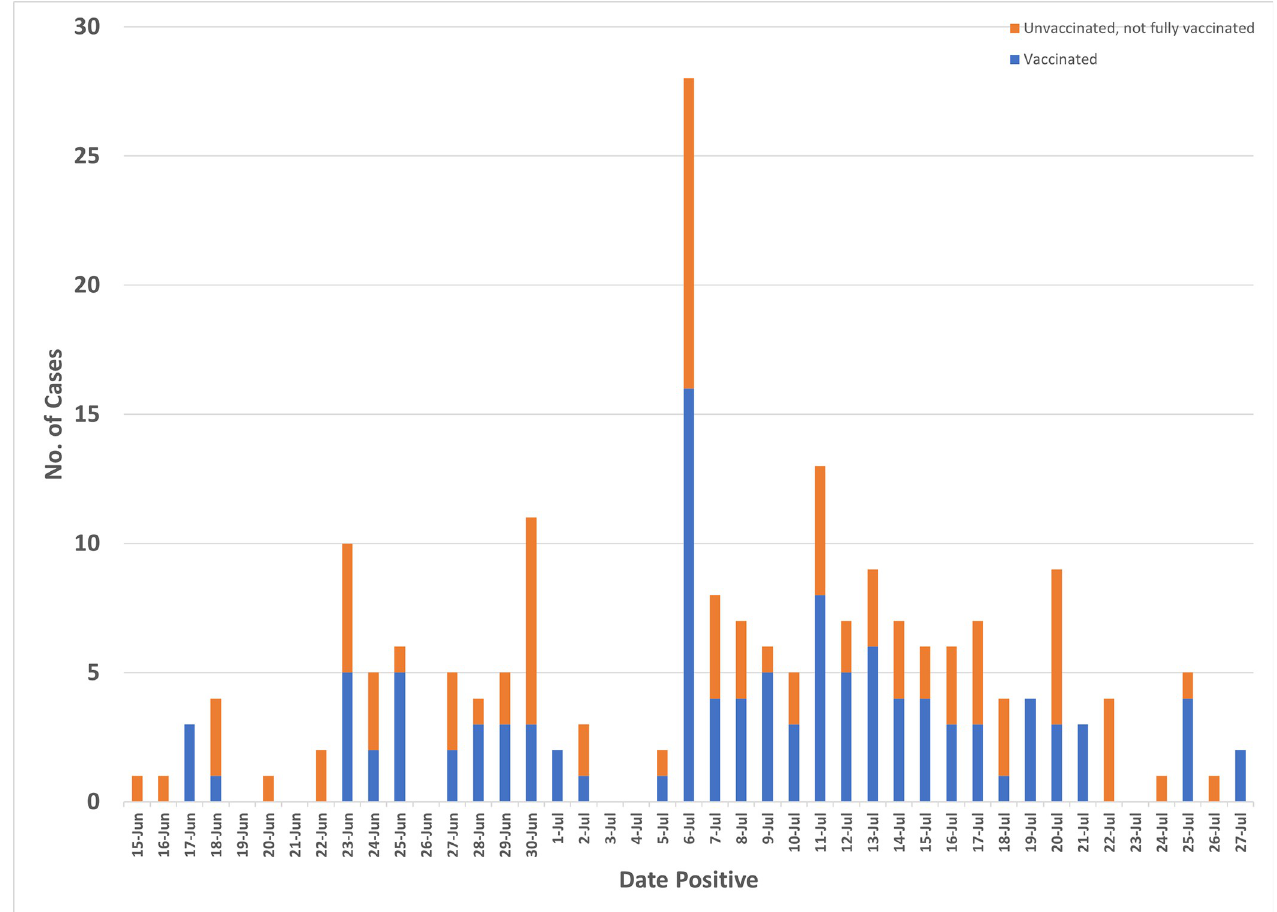
Fig 1. SARS-CoV-2 infections, by date of positivity and vaccination status, USFK, 15 June– 27 July, 2021.